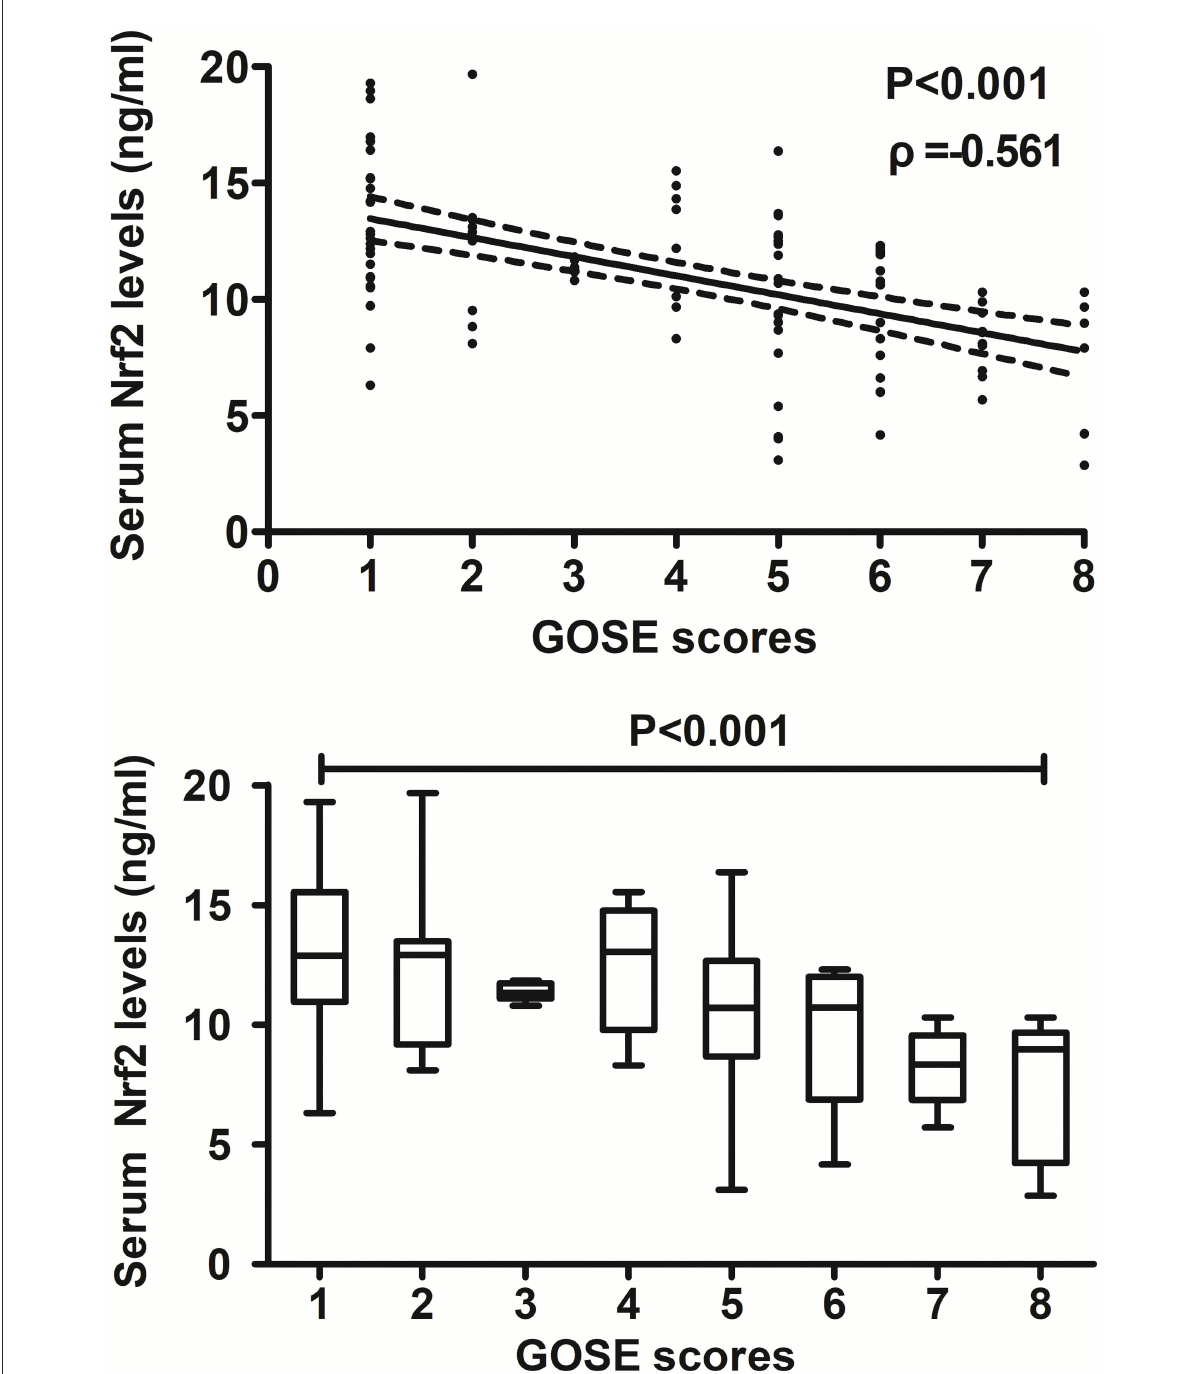
FIGURE6 Relationship between serum nuclear factor erythroid 2-related factor 2 levels and 180-day extended Glasgow Outcome Scale scores after severe traumatic brain injury. Serum nuclear factor erythroid 2-related factor 2 levels were significantly and inversely correlated with extended Glasgow Outcome Scale scores ( P < 0.001) and were substantially different among subgroups divided by extended Glasgow Outcome Scale scores ( P < 0.001). Nrf2 indicates nuclear factor erythroid 2-related factor 2; GOSE, extended Glasgow Outcome